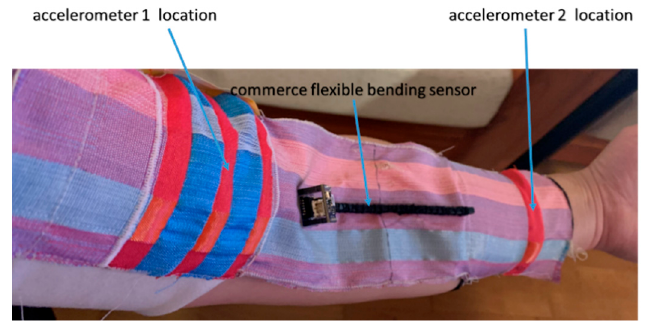
Figure 7. E-textile movement sensor and Bend Labs sensor strapped onto the arm to measure arm joint angle.